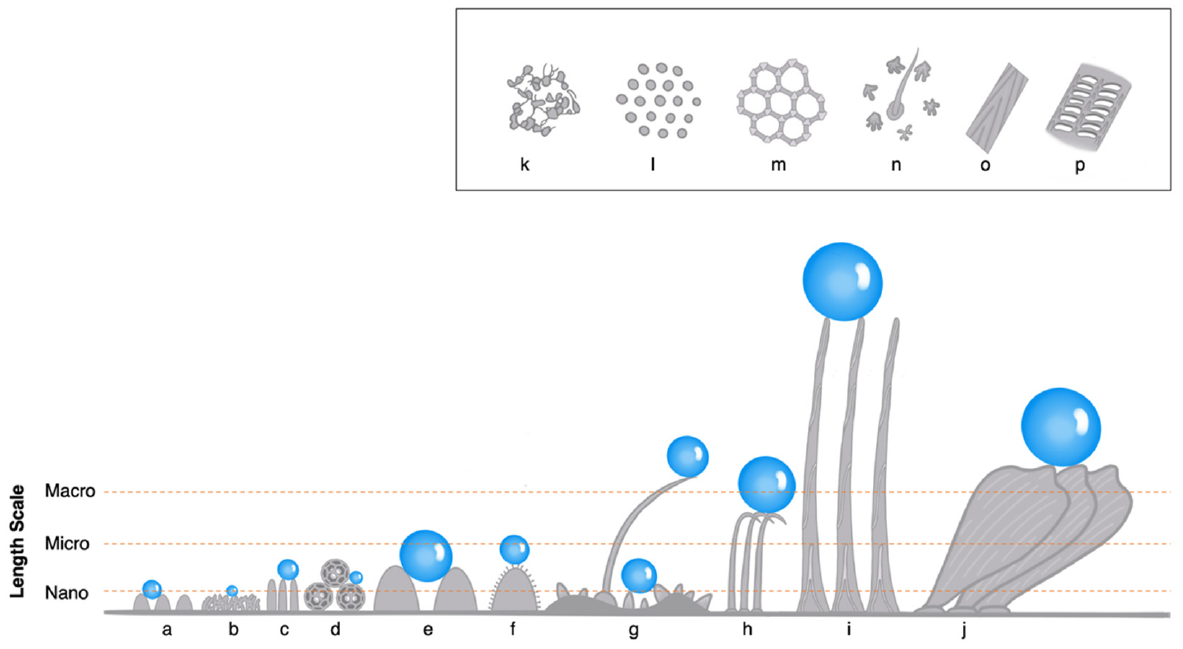
Figure 3. Main illustration: Side profile of select cuticular surface structures of insects ( a ) nano-domes ( b ) disordered nanopillars or wax structures ( c ) ordered nanopillars ( d ) brochosomes ( e ) micro-domes ( f ) hierarchical micro-domes with nanostructures ( g ) hierarchical arrangement of micrasters and hairs with nanogrooves ( h ) microscale hairs ( i ) macroscale hairs with nanogrooves ( j ) cover scales with nanogrooves. Inset: Top view of select cuticle surface structures of insects ( k ) disordered nanopillars or micro-domes ( l ) ordered nanopillars or micro-domes ( m ) polygonal cuticular patterning ( n ) hierarchical arrangement of micrasters and hairs with nanogrooves ( o ) micro- or macroscale hairs with longitudinal nano- or microgrooves ( p ) hierarchical microgrooves with nanoscale cross-ribs separated by longitudinal ridges. Note: cuticular features drawn roughly to length scale, water droplet size enhanced (not to scale) for visualization purposes.